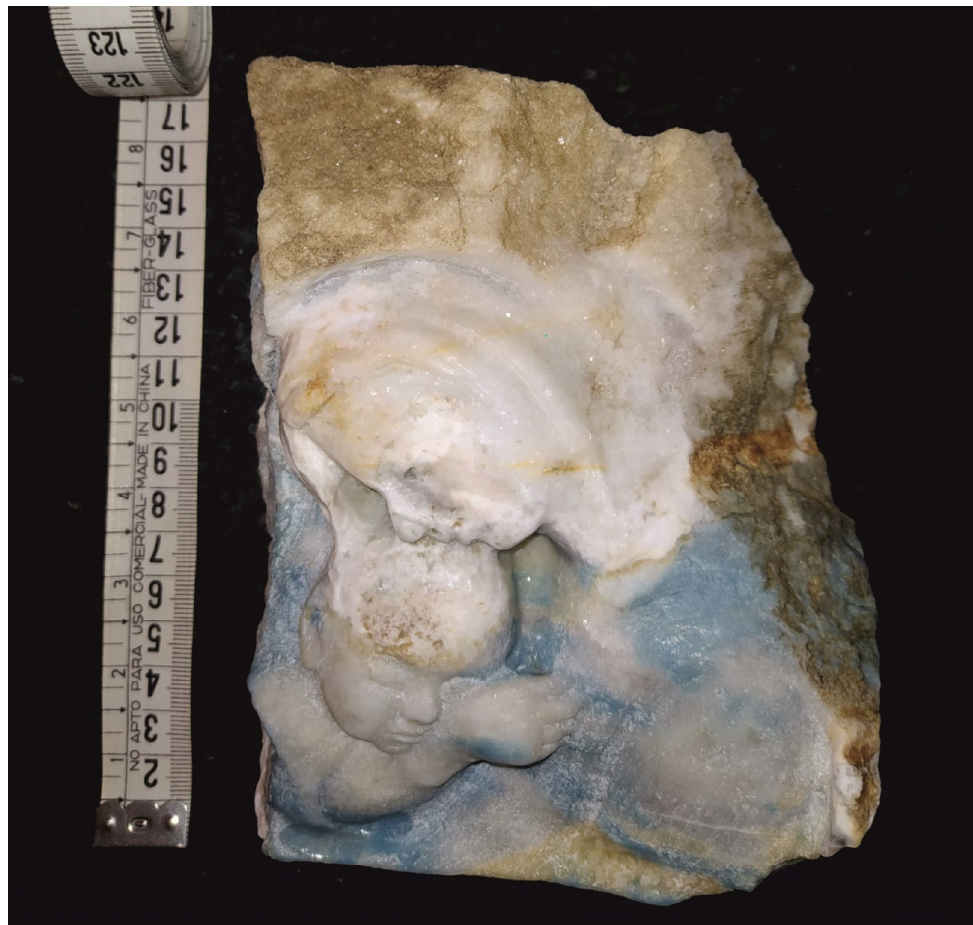
Figure 15. Statue of the Madonna sculpted by the artist Silvio Gaggi (Chiesa Valmalenco) using marble with blue diopside from Sissone valley.